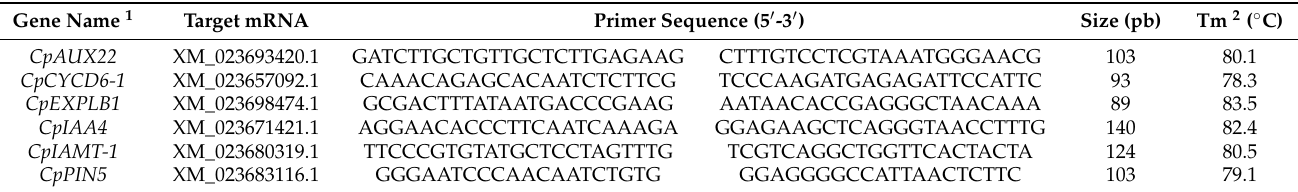
Table 1. Primers used for the